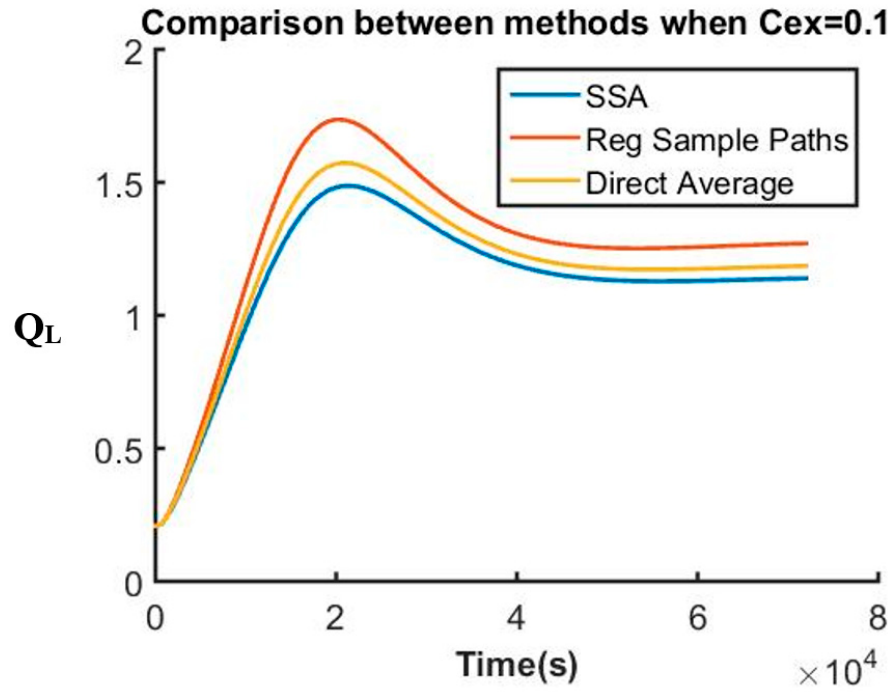
Figure 1. Q L dynamics at a low extracellular inducer concentration (SSA: Stochastic Simulation Algorithm).